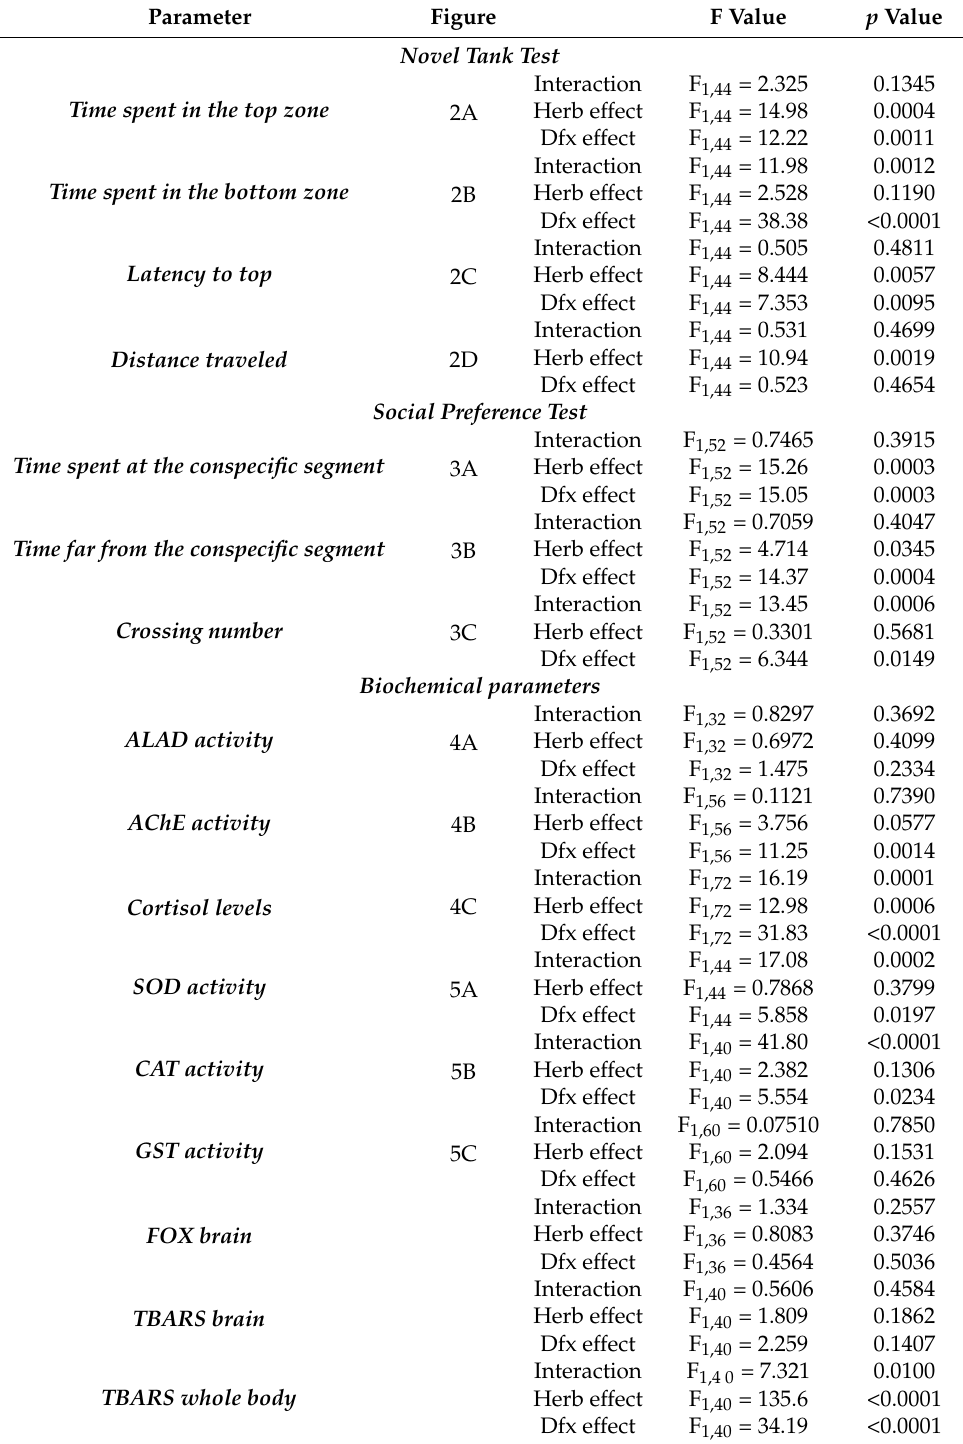
Table 1. Statistical discrimination of the